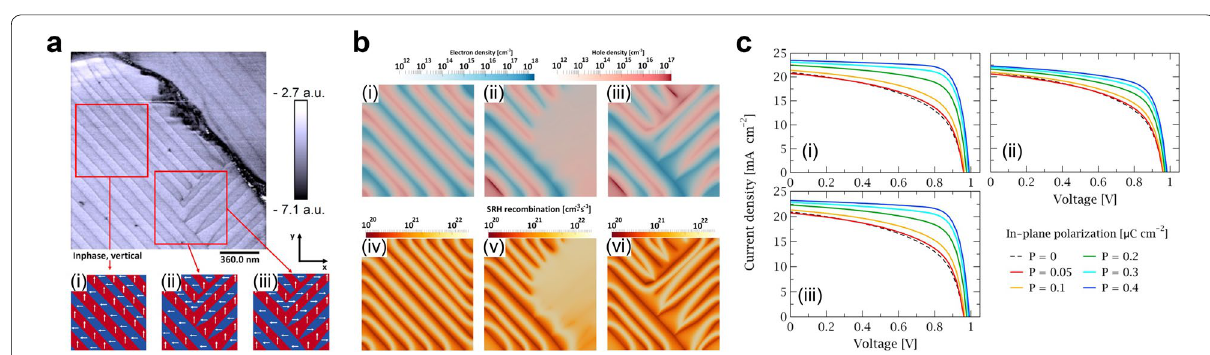
Fig. 10 a PFM image of MAPbI 3 (Cl) domain and polarization orientation. b Simulations of charge carrier densities and SRH recombination at corresponding region of a. c Simulation of J–V characteristic with in‑plane polarization (Reproduced from [95] with copyright permission from © 2018 Elsevier